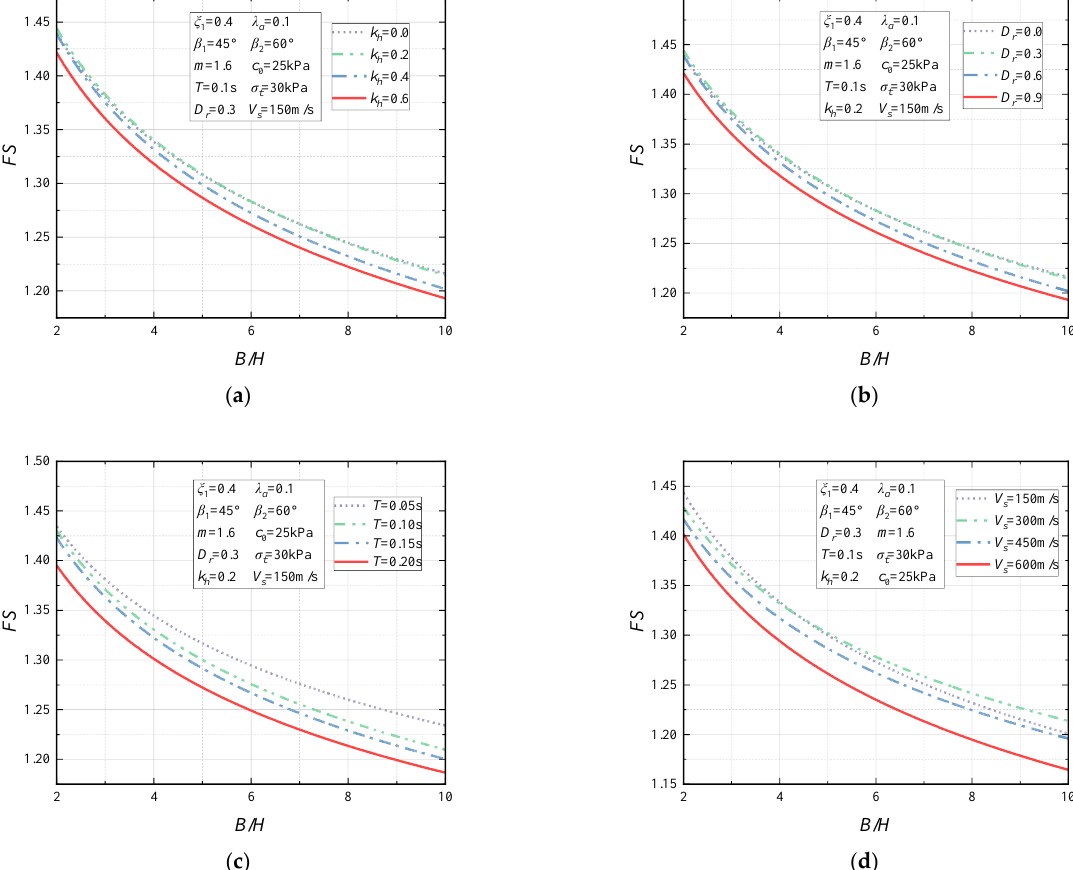
Figure 8. Impacts of seismic factors on the stability for 3D two-step slopes: ( a ) horizontal seismic k ; ( b ) damping ratio D ; ( c ) period T ; ( d ) S-wave propagating velocity coefficient h coefficient k h ; ( b ) damping ratio D ; ( c ) period T ; ( d ) S-wave propagating velocity V s